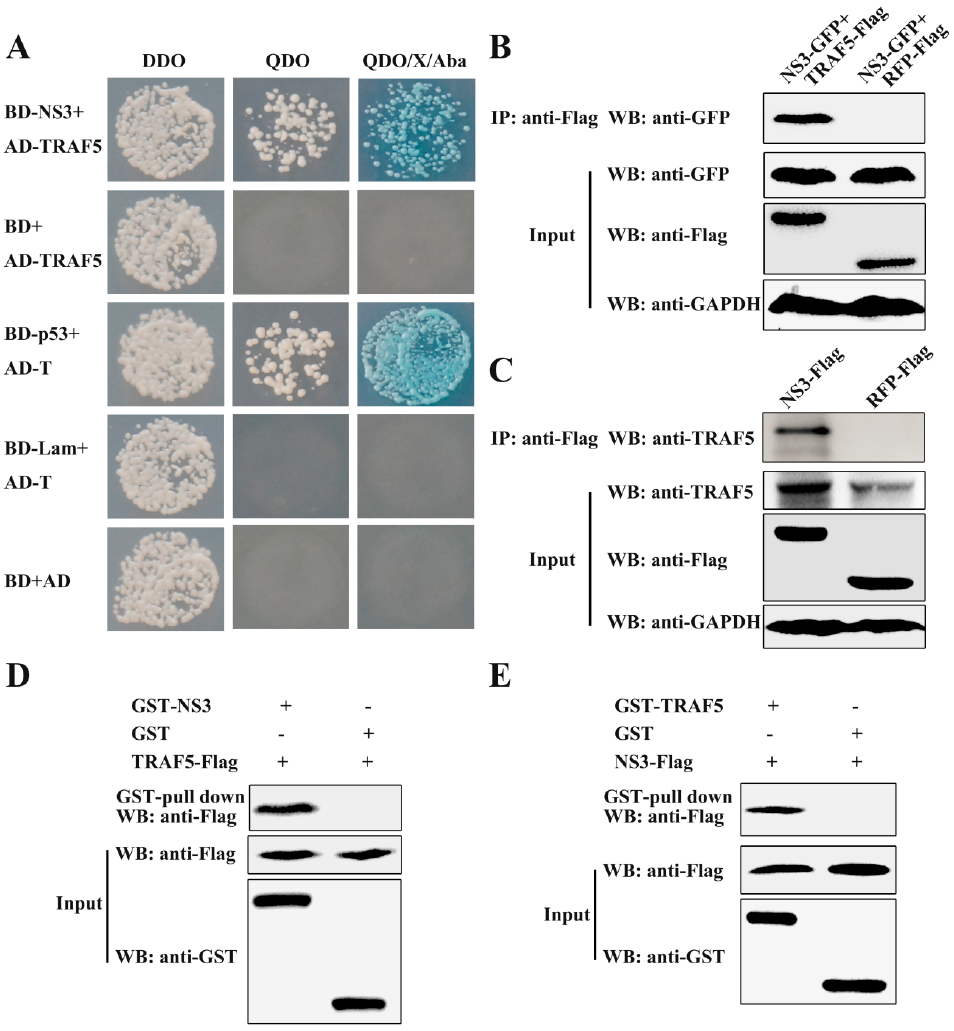
Figure 1. Interaction of non-structural protein 3 (NS3) with tumor necrosis factor receptor-associated factor 5 (TRAF5). ( A ) Interaction of NS3 and TRAF5 by the Y2H system. The yeast strain Y2HGold was cotransformed with the full-length TRAF5 (AD-TRAF5) and the bait plasmid BD or BD-NS3. Cotransformations with BD/AD, BD-Lamin/AD-T and BD-p53/AD-T were used as blank, negative and positive controls, respectively; ( B ) Exogenous co-immunoprecipitation (co-IP) analysis of NS3 and TRAF5 in porcine alveolar macrophages (PAMs). Cells were co-transfected with plasmids NS3-GFP and TRAF5-Flag; co-transfection with NS3-GFP and RFP-Flag as a negative control. In total, 20% of the cell extract was subjected to the input assay to assess GAPDH, Flag-fusion, and GFP-fusion protein levels. The rest of the extract was subjected to IP assay and precipitated proteins were detected by Western blot with a mouse anti-GFP mAb; ( C ) Endogenous co-IP analysis of NS3 and TRAF5 in PAMs. PAMs were transfected with plasmid NS3-Flag; transfection with RFP-Flag as a negative control. The precipitated proteins were detected by western blot with a rabbit anti-TRAF5 pAb; ( D ) GST-NS3 pull-down assay. The glutathione S -transferase (GST) and GST-NS3 proteins expressed in E. coli Rosetta (DE3) cells were immobilised on a glutathione agarose resin, followed by incubation of the resin with the HEK293T cell lysates containing TRAF5-Flag protein. The bound proteins were detected by Western blot using a mouse anti-Flag mAb. The expression of input proteins (TRAF5-Flag, GST or GST-NS3) was confirmed by Western blot using a mouse anti-Flag mAb and a mouse anti-GST mAb, respectively; ( E ) GST-TRAF5 pull-down assay. The GST and GST-TRAF5 proteins expressed in E. coli Rosetta (DE3) cells were immobilised on the glutathione agarose resin, with incubation with the HEK293T cell lysates containing the NS3-Flag protein. The eluted proteins were detected by Western blot using a mouse anti-Flag